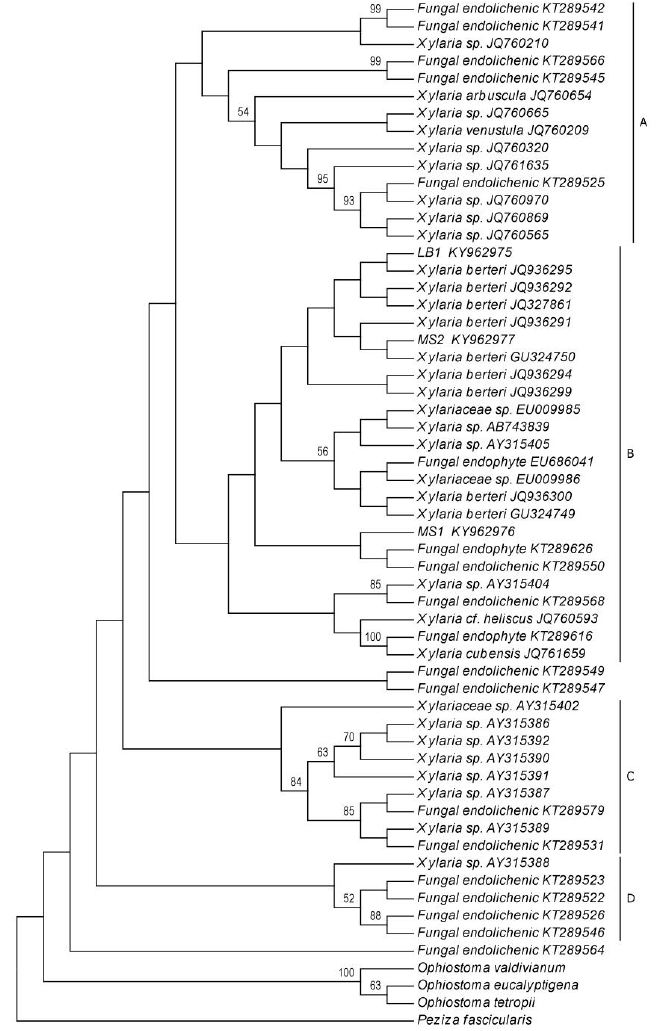
Figure 2. Phylogenetic relationships among endolichenic fungi isolated from Cladonia curta and sequences of endophytic fungi from plants (lichens [1,9], liverworts [43] and BLASTn [44]). MS1, MS2 and LB1 corresponding to sequences obtained in the present study. The phylogenetic tree inferred by maximum likelihood based on one-locus ITS region of rDNA dataset. The numbers at each internode indicates bootstrap support values. Three species of Ophiostoma ( O. valdivianum , O. eucalyptigena and O. tetropii ) and Peziza fascicularis were used as